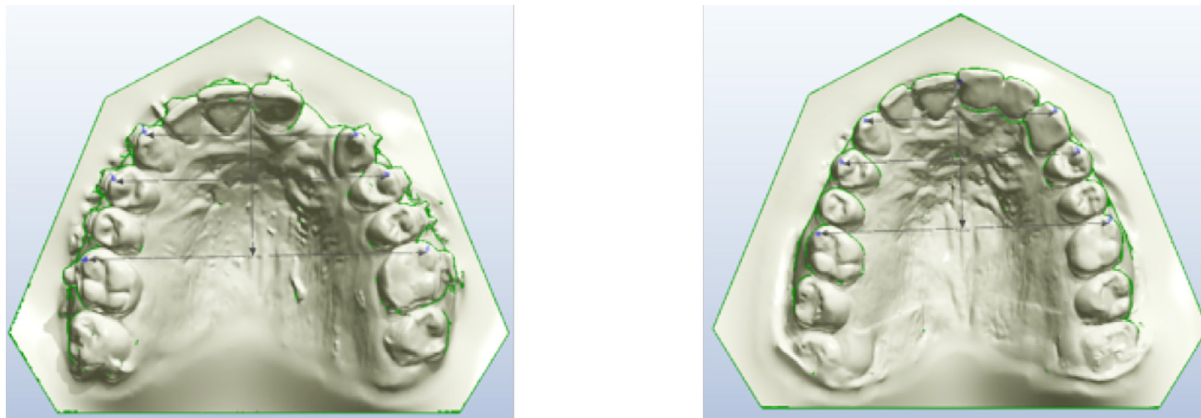
Figure 1- Landmarks used for the analysis of the digital images for group FG before and after fixed partial denture